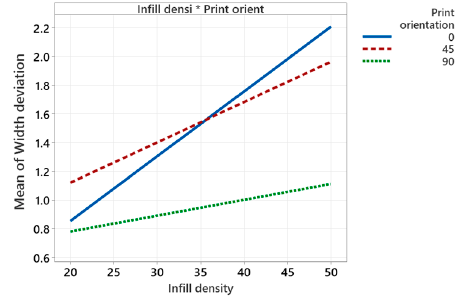
Figure 10. Interaction plot for width deviation.